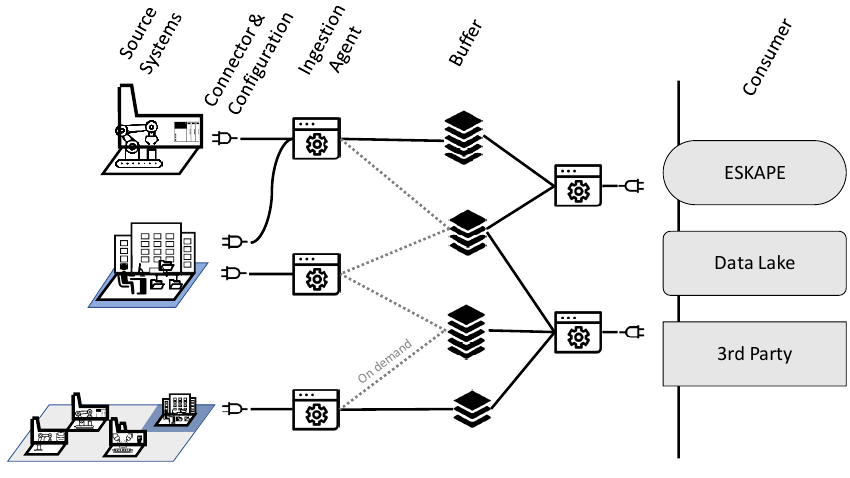
Figure 3. Ingestion agents and their interaction with the source and target